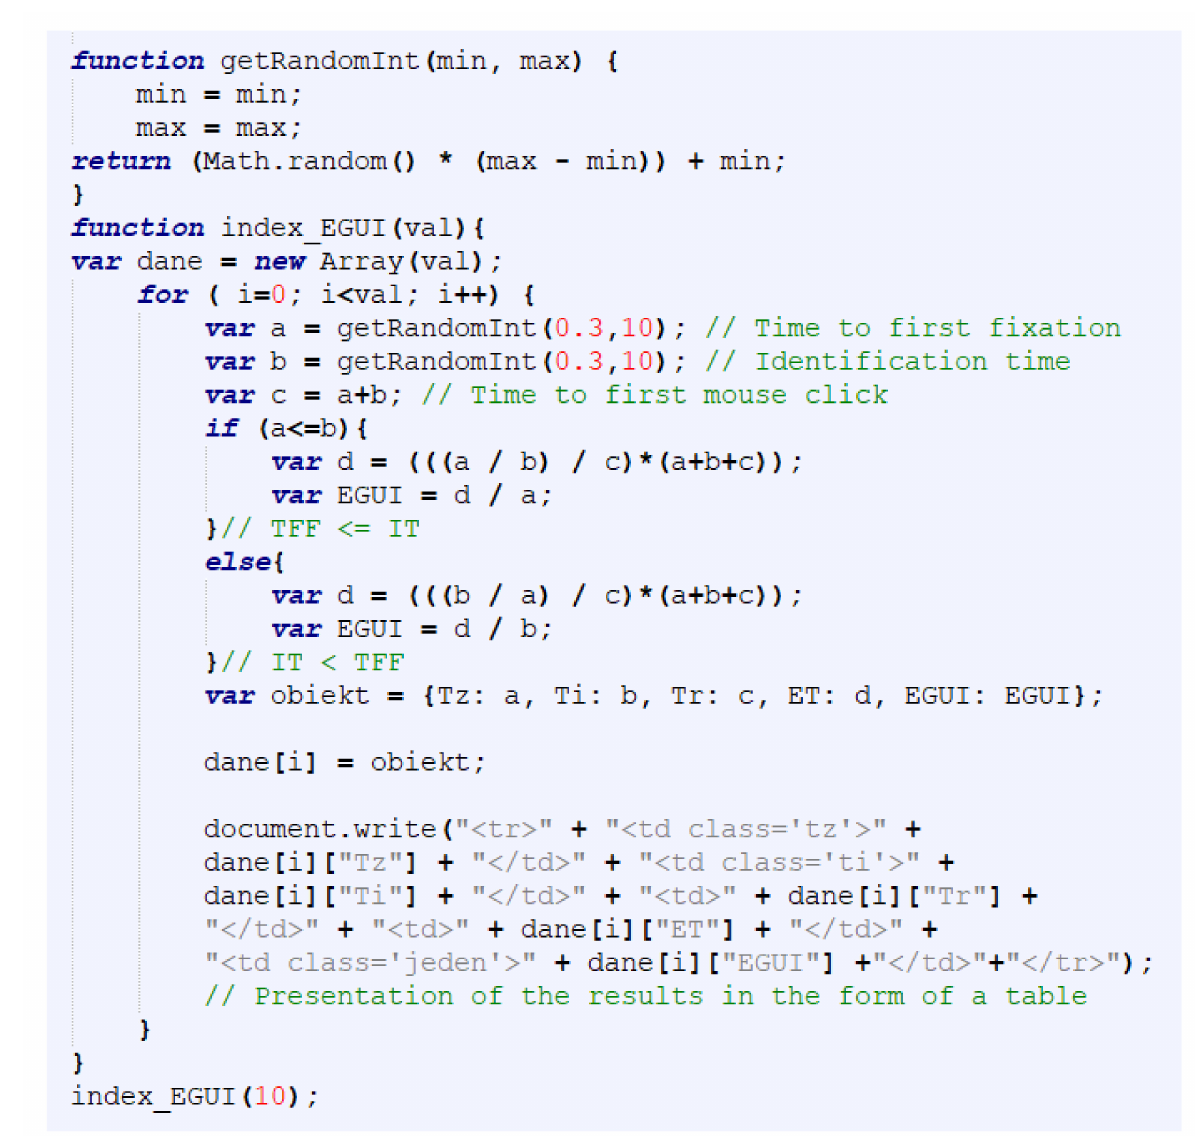
Figure 4. Program for testing the GUI effectiveness